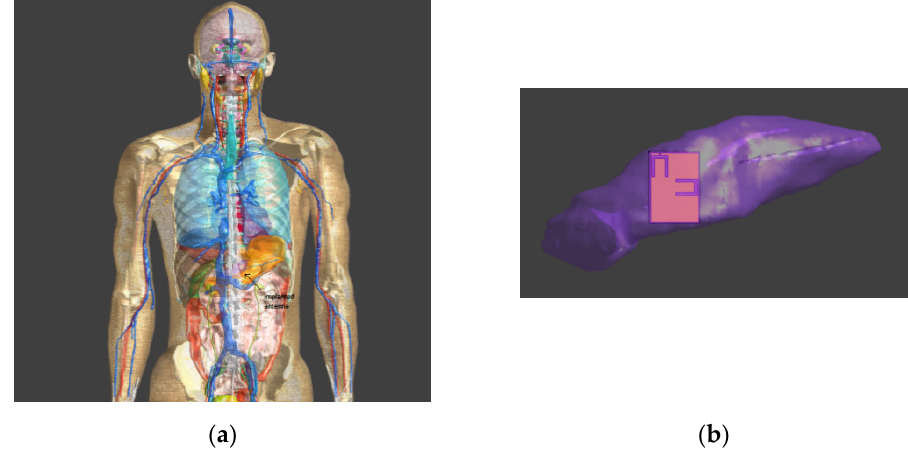
Figure 21. Anatomical model ( a ) and simulation of the implanted antenna on the pancreas surface ( b ) .